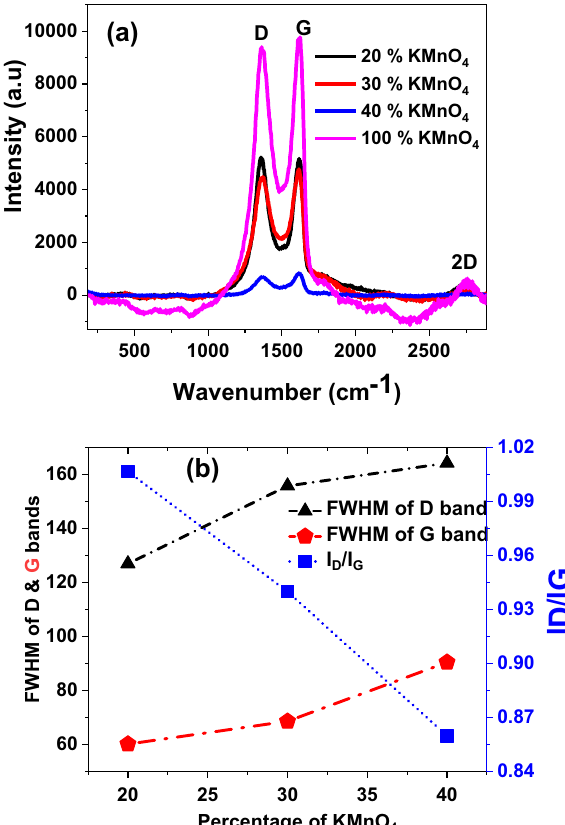
Figure 7. ( a ) Room temperature Raman spectra of a series (varying the % ages of KMNO 4 ) of controlled oxidized GO nanosheets samples ( b ) Variation in FWHM of D and G bands and I D /I G ratio of controlled oxidized GO nanosheets samples versus concentration of KMNO 4